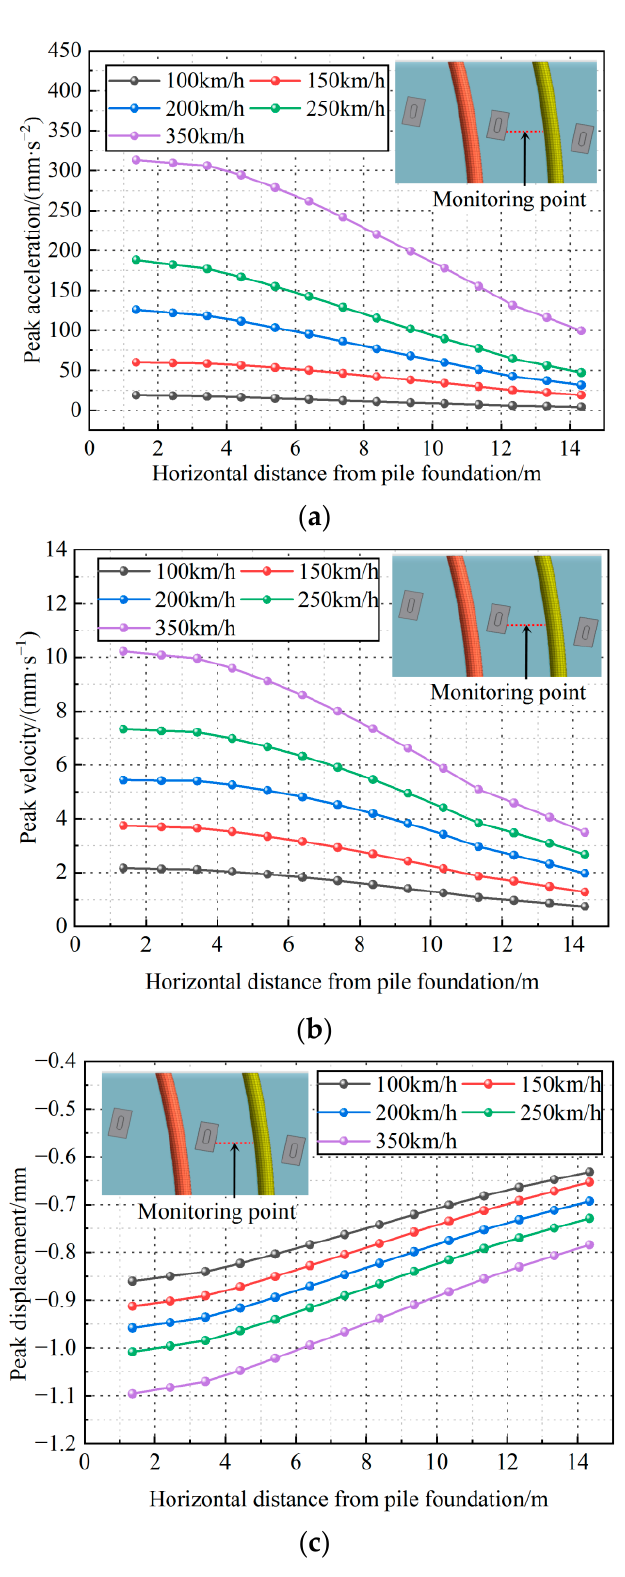
Figure 13. Horizontal dynamic response characteristics of the foundation for different train speeds. ( a ) Peak vibration acceleration. ( b ) Peak vibration velocity. ( c ) Peak vibration displacement.